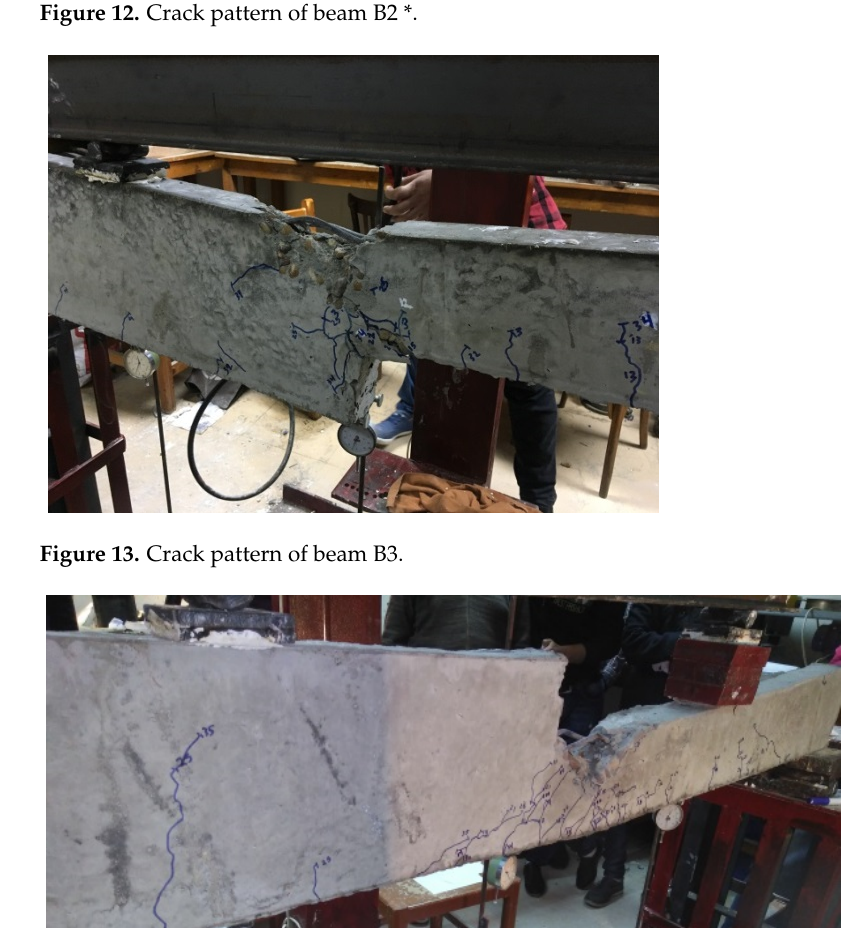
Figure 14. Crack pattern of beam B3 *.